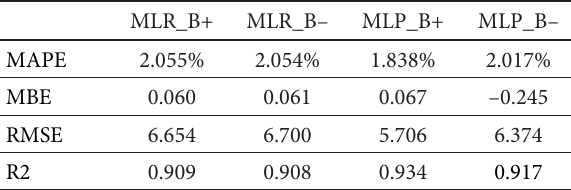
Table 5. Values of forecasting performance